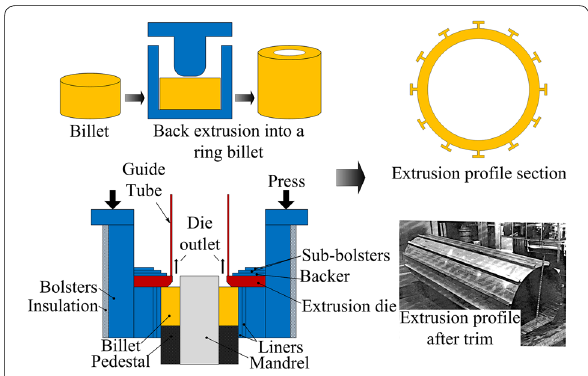
Figure 4 Extrusion process diagram for large-size cylindrical component with stiffeners (Redraw based on Refs. [18,